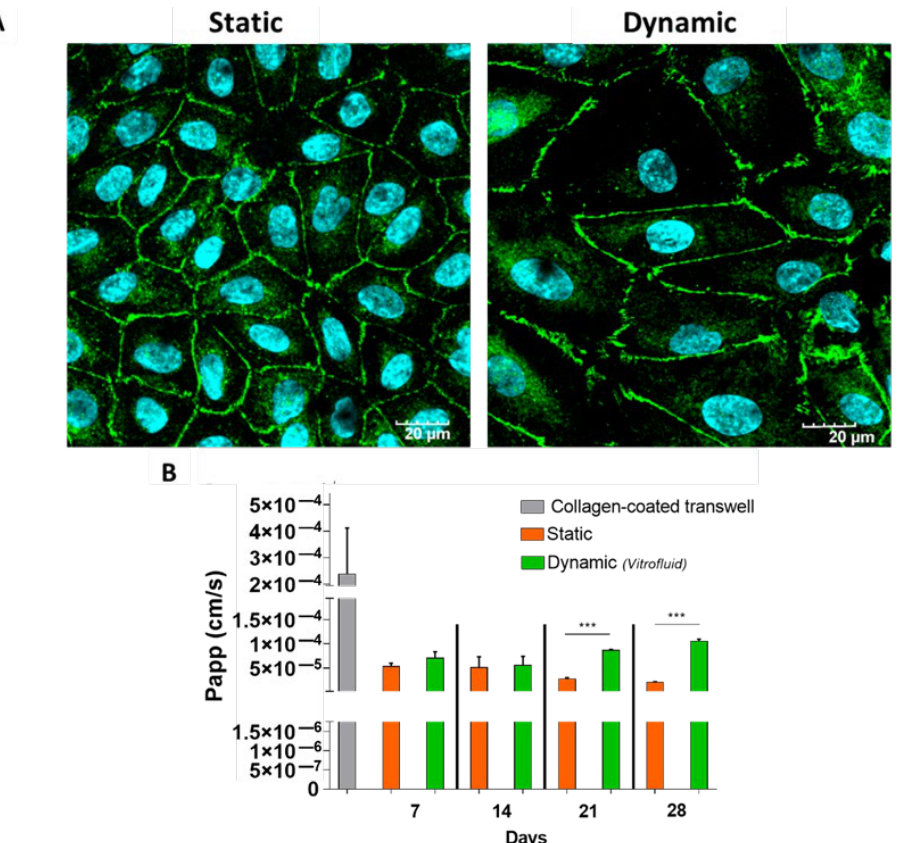
Figure 5. Time course characterization of barrier tightness under static and dynamic conditions: ( A ) Fluorescent staining of RPTECs to label tight junctions (ZO-1, green) and nuclei (DAPI, cyan) after 7 days in static or dynamic conditions. ( B ) Apparent permeability (Papp) measured after 1 h of incubation with 10 µ g/mL Lucifer Yellow on days 7, 14, 21, and 28 (data are expressed as mean ± SD; n = 3; Student’s t -test; *** p ≤